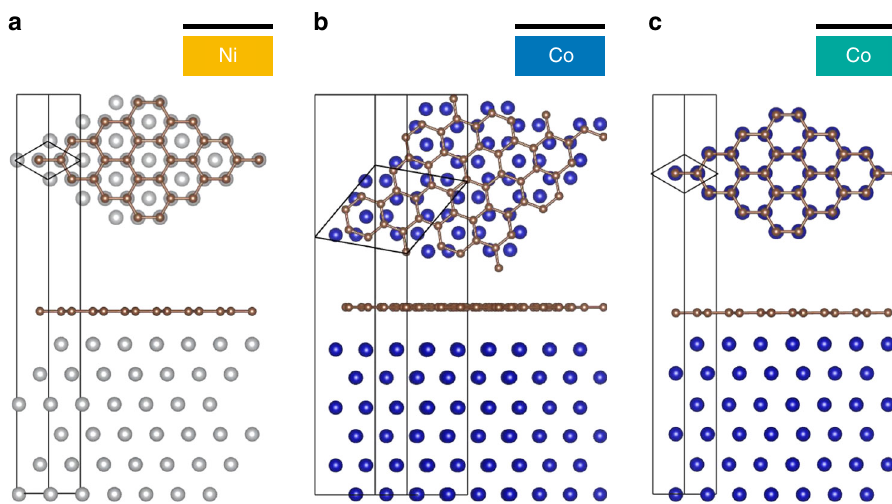
Fig. 5 Geometries of the interfaces considered in calculations. a Lowest energy epitaxial Ni/Gr interface. For the Co/Gr interface, two cases have been studied. b A rotated Co/Gr interface, exhibiting a weak interaction similar to that expected for the low temperature evaporation of a top Co electrode on graphene, and c a strong epitaxial interaction. Ab-initio calculated layer separation for the three con fi gurations: a Ni – Gr = 2.2 Å, b Co – Gr = 3 Å, and c Co – Gr = 2.15